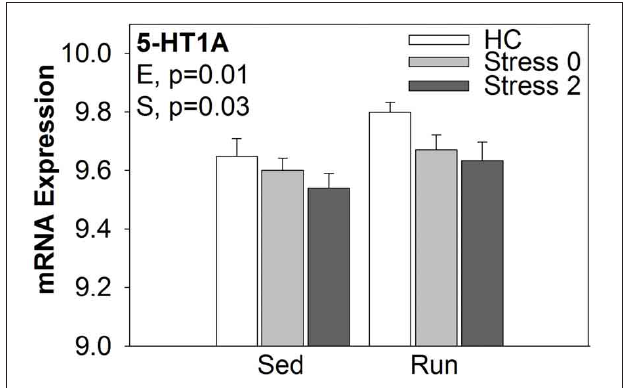
FIGURE 6 | mRNA expression of 5-HT1A in the